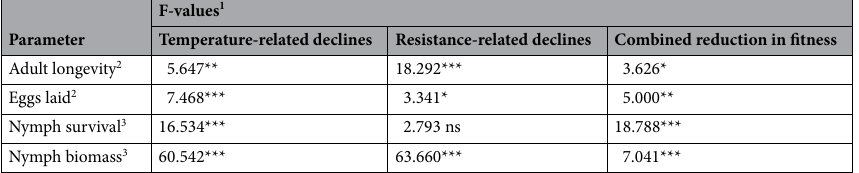
Table 4. F-values from univariate GLMs for factors producing a decline in fitness of Nilaparvata lugens on resistant rice over a range of temperatures (see also Fig. 5). 1 ns = P > 0.05, * P ≤ 0.05, ** P ≤ 0.01, *** P ≤